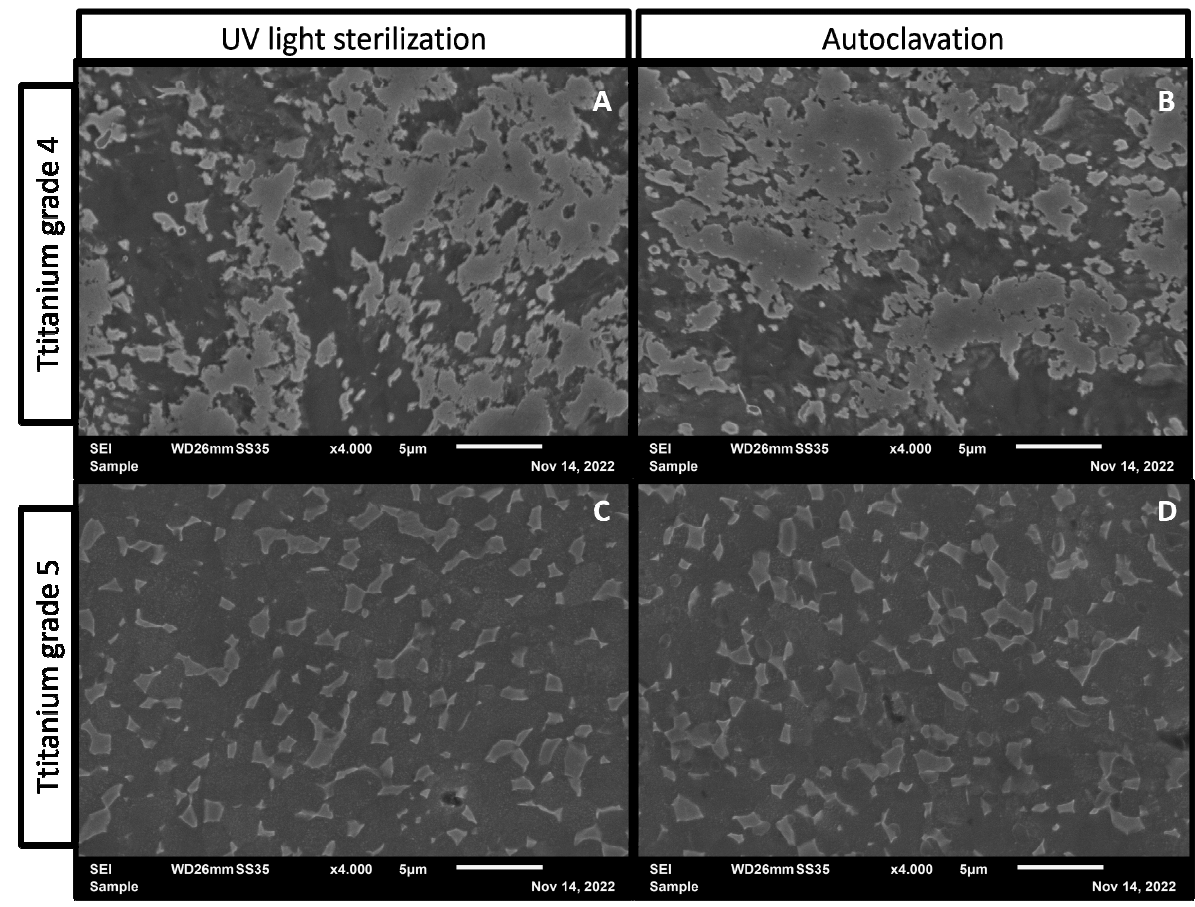
Figure 3. Sterilized titanium surface images performed by scanning electron microscopy. ( A ) Sur ‐ face of titanium grade 4 sterilized with UV light; ( B ) surface of autoclaved titanium grade 4; ( C , D ) surface of titanium grade 5 samples after UV light sterilization and